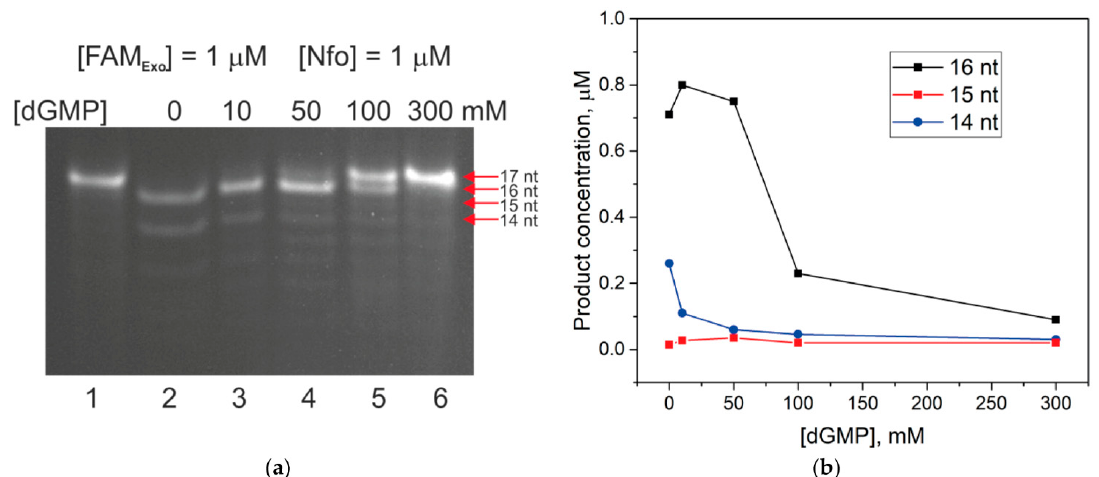
Figure 7. The ratio of the initial DNA substrate to products during the interaction between Nfo and FAM Exo in the presence of 2  ‐ deoxyguanosine monophosphate ( a ). Amounts of 16 ‐ and 15 ‐ mer products in the reaction mixture as a function of dGMP concentration ( b ). [Nfo] = 1.0 μ M and [FAM Exo ] = 1.0 μ M; [dGMP] varied from 0 to 300 mM.